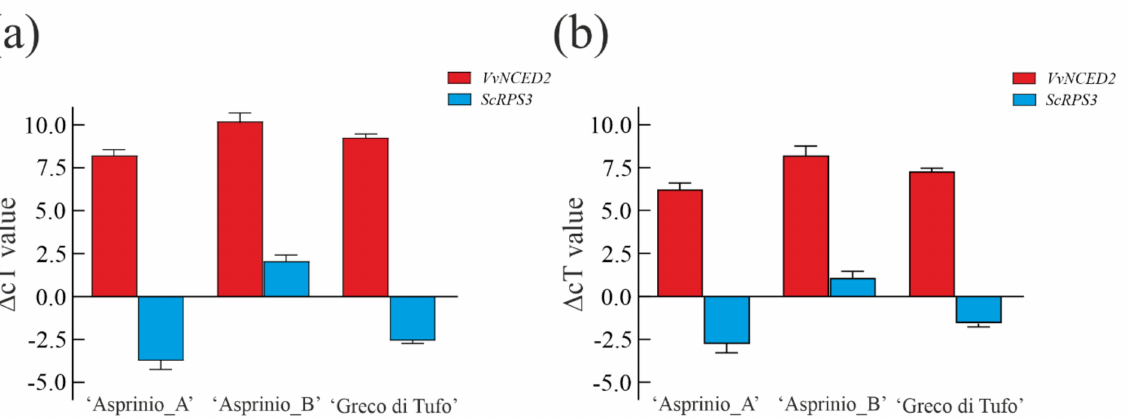
Figure 6. In ( a , b ), relative quantification of grapevine and yeast DNA in ‘Asprinio_A’, ‘Asprinio_B’ and ‘Greco di Tufo’ samples in 2019 and 2020 vintages, respectively. Data are means of relative quan- tification measurements based on the ∆ Ct Method ± SD; n = 3 biological replicates for each